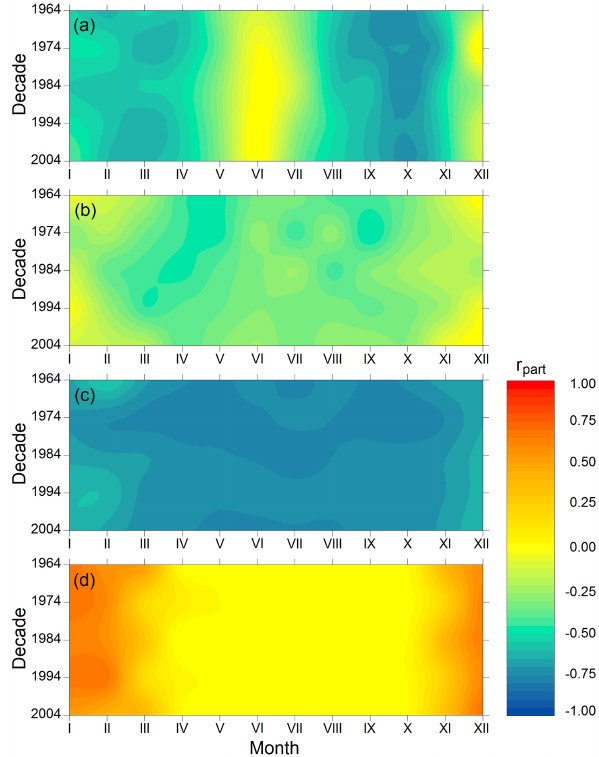
Figure 3. Partial correlation coefficients ( r part ) of the effects of (a) SZA, (b) TOC, (c) cloud cover, and (d) surface UV albedo on the daily doses in individual months and decades; the decades are labeled only by their initial